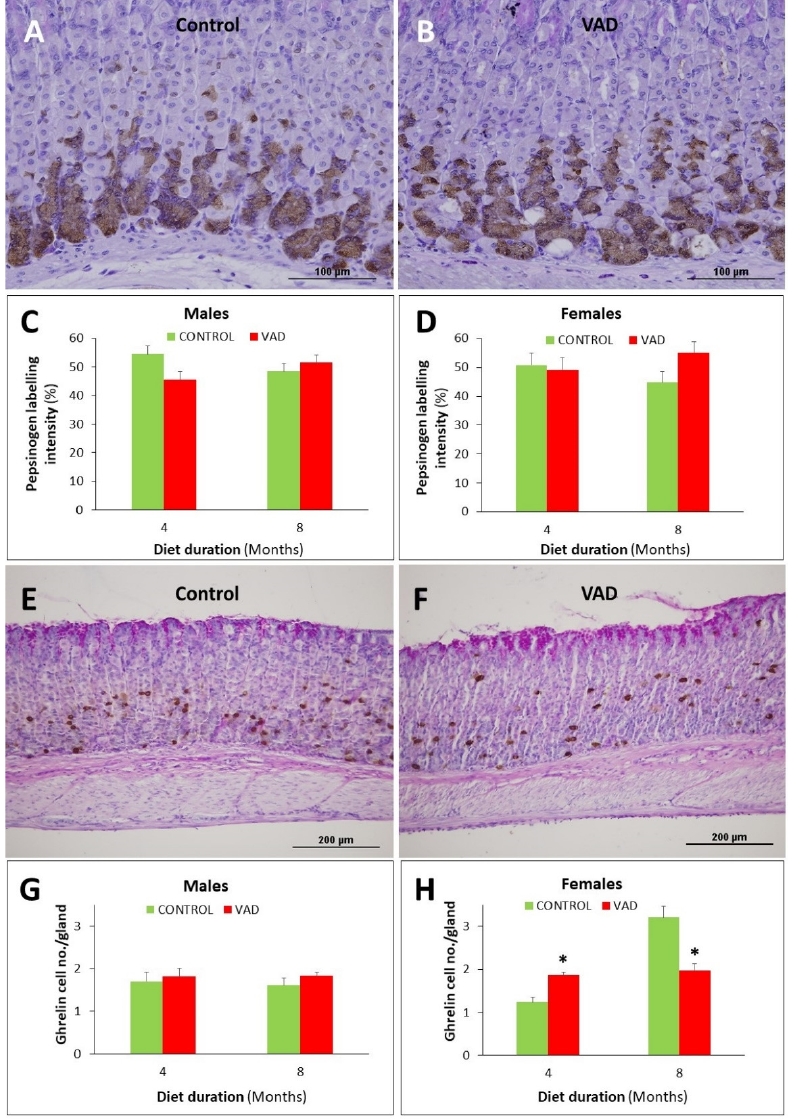
Figure 10. Immunolocalization and analysis of pepsinogen ( A – D ) and ghrelin ( E – H ) secreting cells in the gastric mucosae of control and VAD mice. Images are taken from 8-month control and VAD male mice. Zymogenic cells expressing pepsinogen appear brownish in the base segment of the gastric glands ( A , B ). Quantification demonstrates no significant difference in the labeling intensity of control ( C ) versus VAD ( D ) tissues. Ghrelin-secreting cells are scattered in the gastric mucosae of control ( E ) and VAD ( F ) mice and their numbers are increased in female 4-month VAD mice ( H ) and reduced by 8 months. Scale bars = 100 ( A , B ) and 200 ( E , F ) µ m. * p <